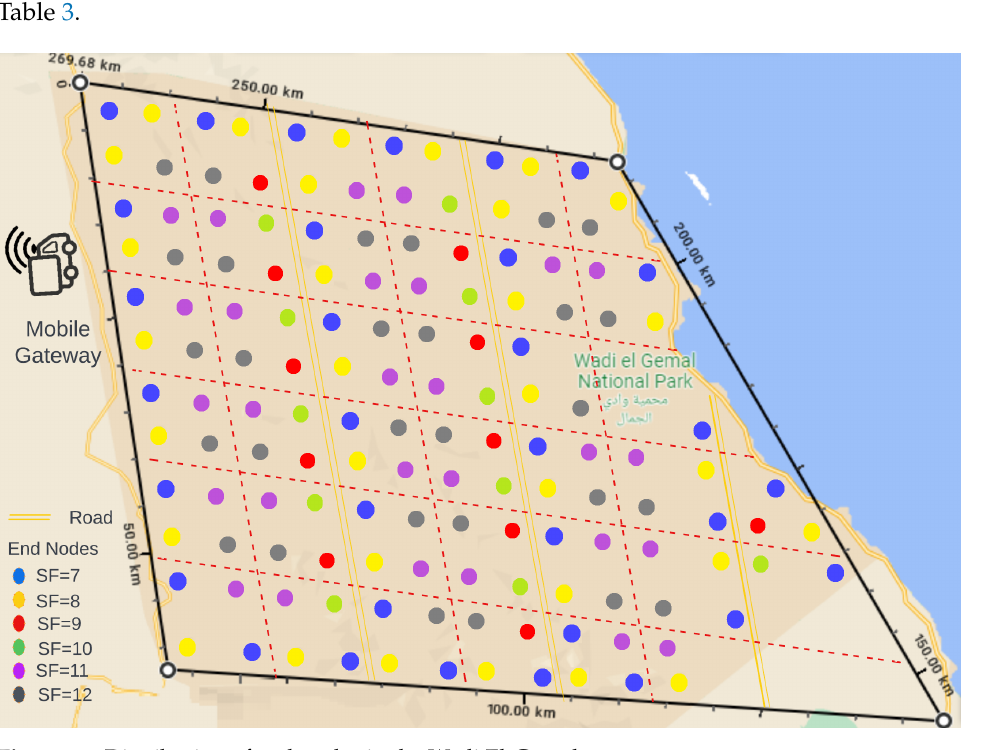
Figure 17. Distribution of end-nodes in the Wadi El-Gemal